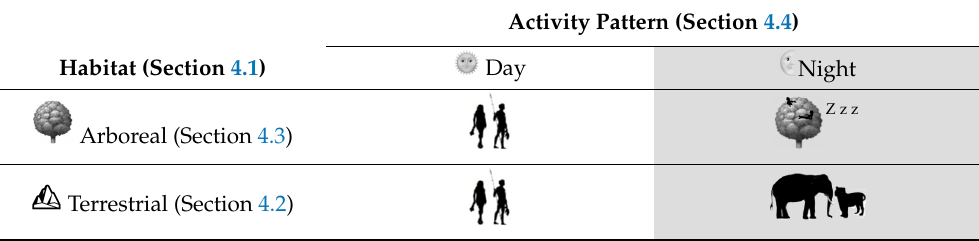
Table 1. Spatio-temporal niche partitioning of apex megafauna (humans, elephants, and tigers) in the Malay Peninsula during the Late Quaternary. Humans are facultative arborealists, whereas elephants and tigers are obligate terrestrialists; humans avoid forest floor at night; elephants and tigers avoid open areas during the day. This table outlines Section 4 of this paper (the numbers of which are noted in bracket)).